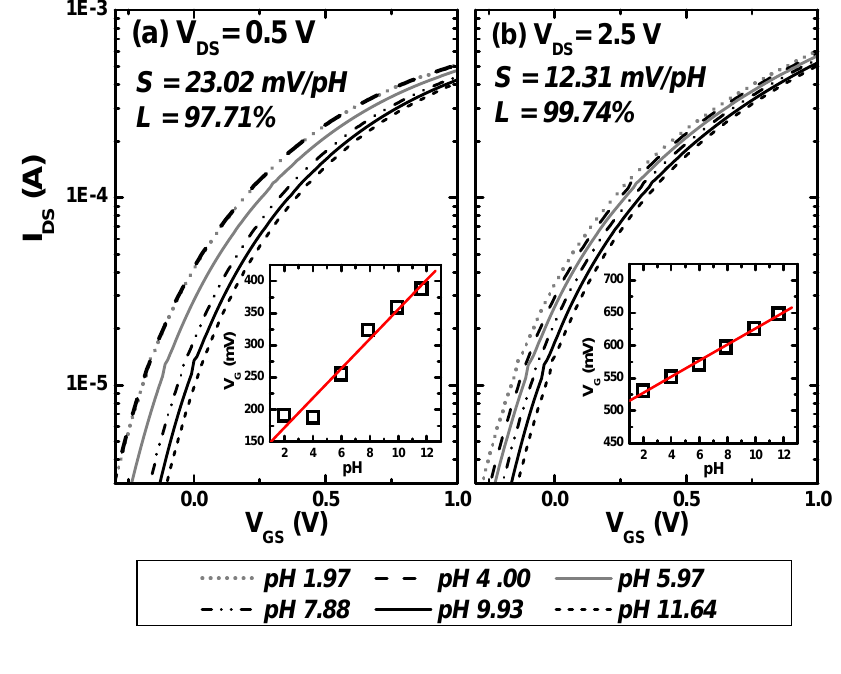
Figure 7. The I = 2.5 V. Insets show calibration curves corresponding to I V DS